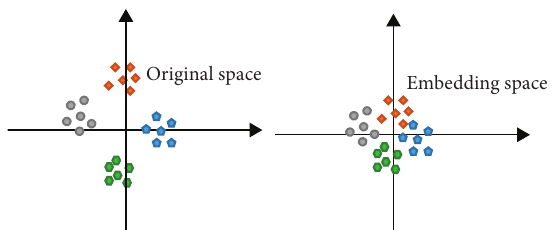
Figure 2: Visual explanation of hubness phenomenon. When a sample point is projected from the original space to the embedding space, the discriminative information in the original space is very likely to be lost, so the sample points belonging to the same class will be closer to other classes, which is especially obvious when mapping from high-dimensional space to low-dimensional